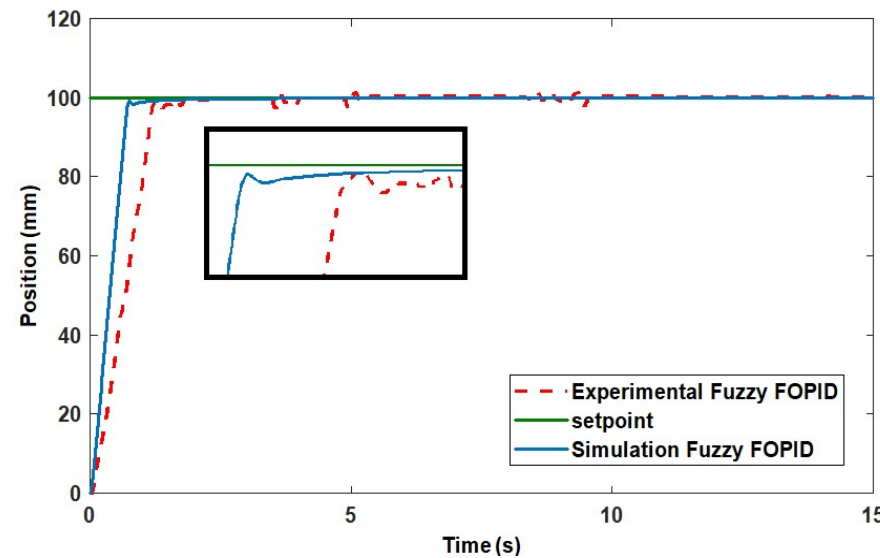
Figure 15. Fuzzy FOPID simulation and experimental performances.